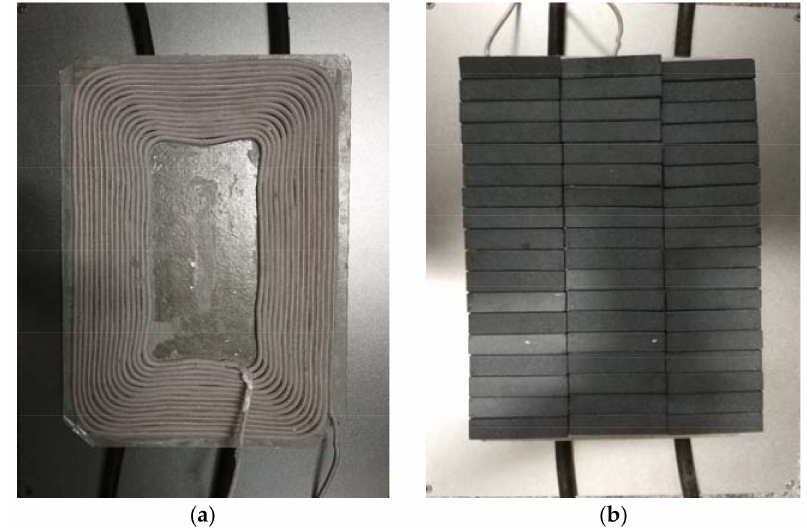
Figure 17. Pickup coil physical map. ( a ) couplings coil; ( b ) couplings coil with magnetic